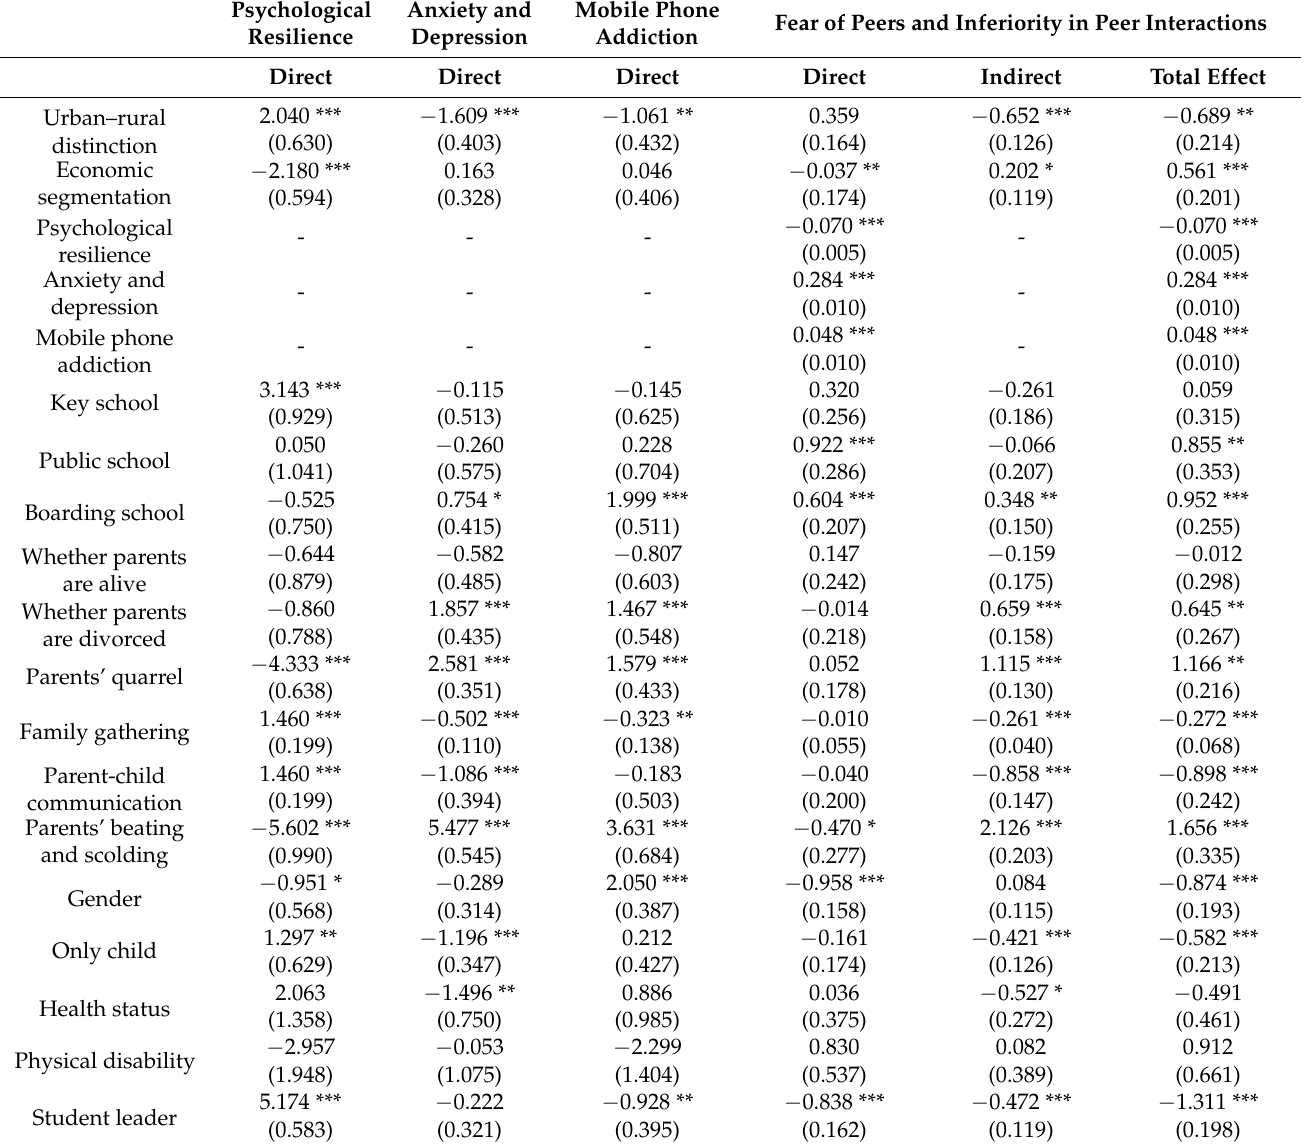
Table 3. Estimation results of the structural equation